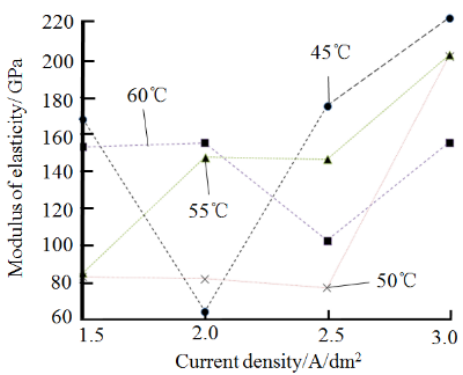
Figure 9. Curves of the relationship between current density, bath temperature, and the elastic modulus of the plated layer.